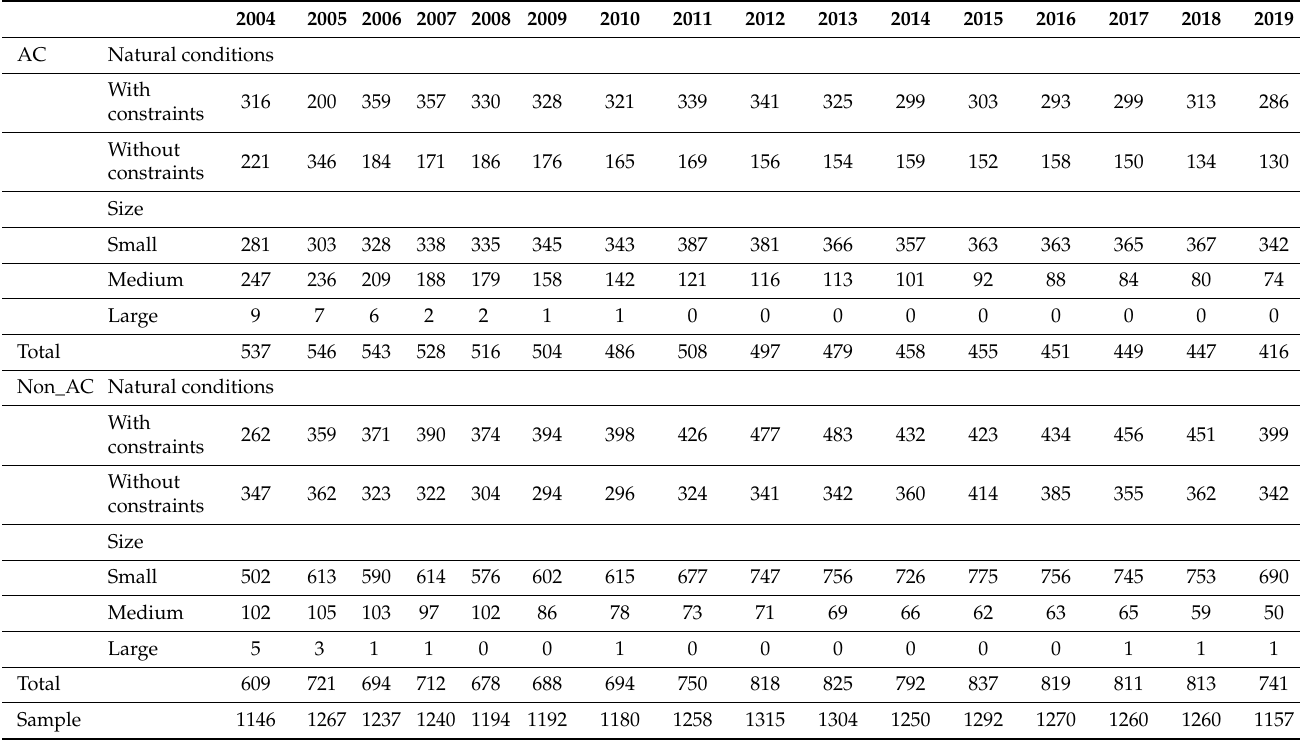
Table 1. Research